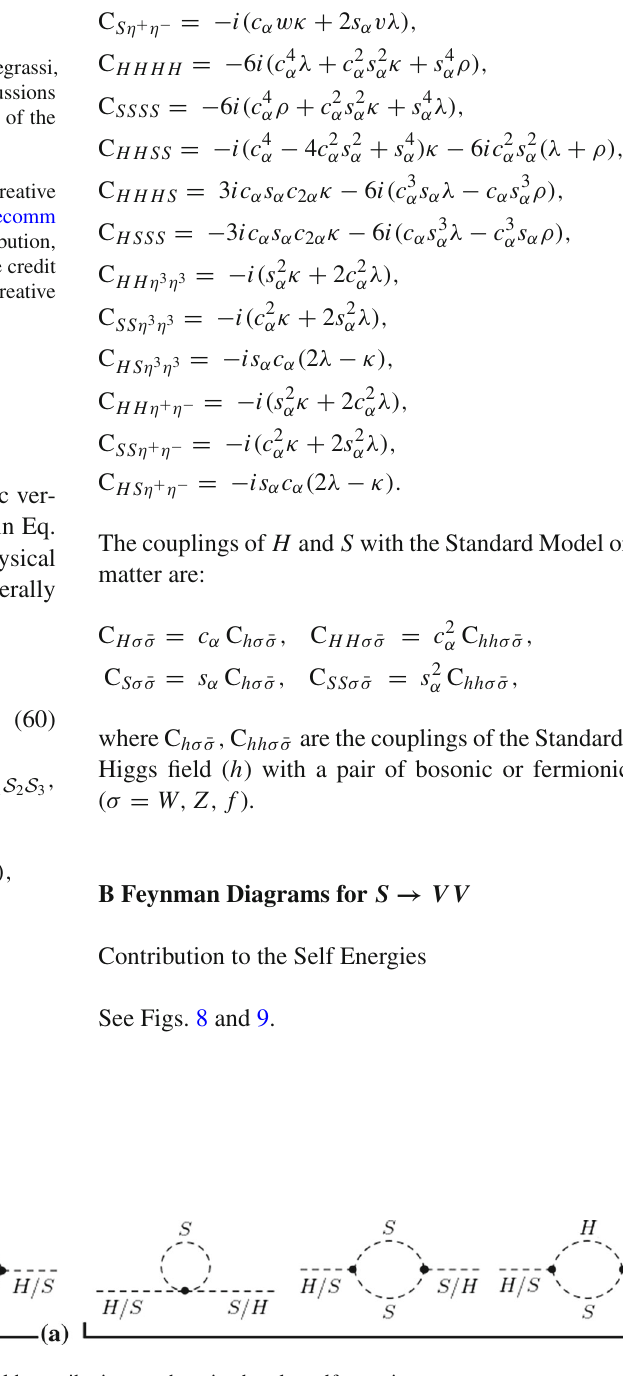
Fig. 8 a S field contributions to the scalar self-energies; b S field contributions to the mixed scalar self-energies